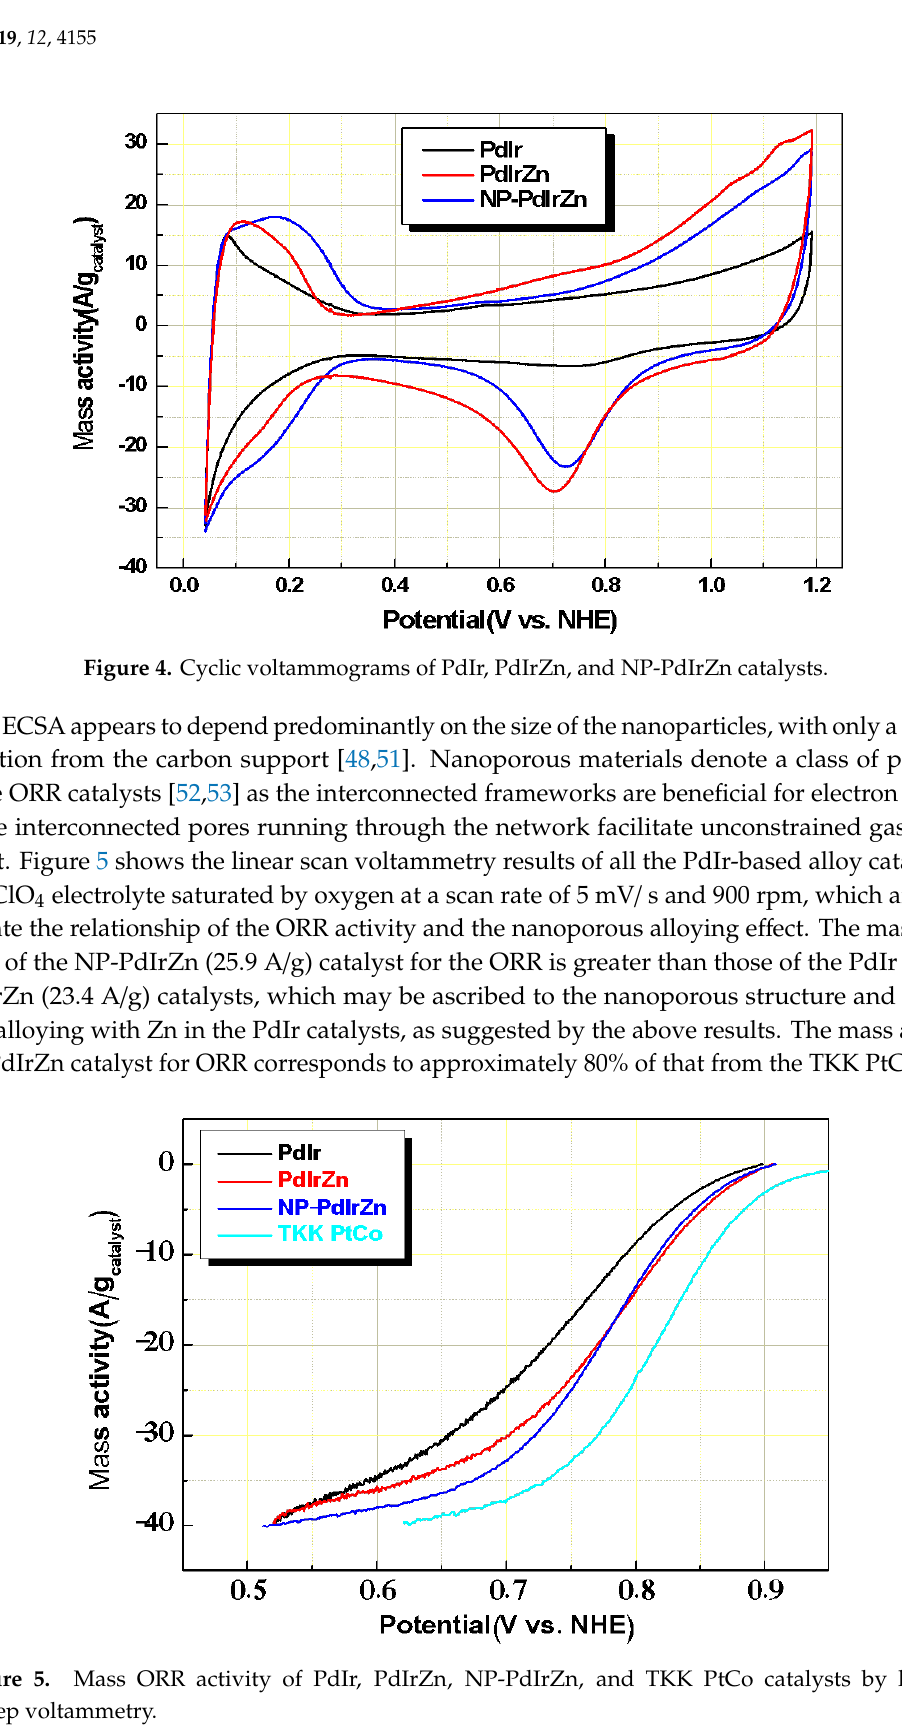
Figure 6 . Single-cell performances of PdIr, PdIrZn, NP-PdIrZn, and TKK PtCo catalysts. respectively, which represents the mixed activation- and Ohmic-controlled voltage of the PEMFC. The cell performance under HT-PEMFC conditions of the NP-PdIrZn catalyst indicates a higher activity than those of the PdIr and PdIrZn catalysts and it is 94.2% of the cell performance of the MEA based on the TKK PtCo catalyst. The NP-PdIrZn/C had a similar performance to the PdNiCu@PdIr/C (0.67 V), which displayed the best single-cell performance among PdIr-based catalysts in previous